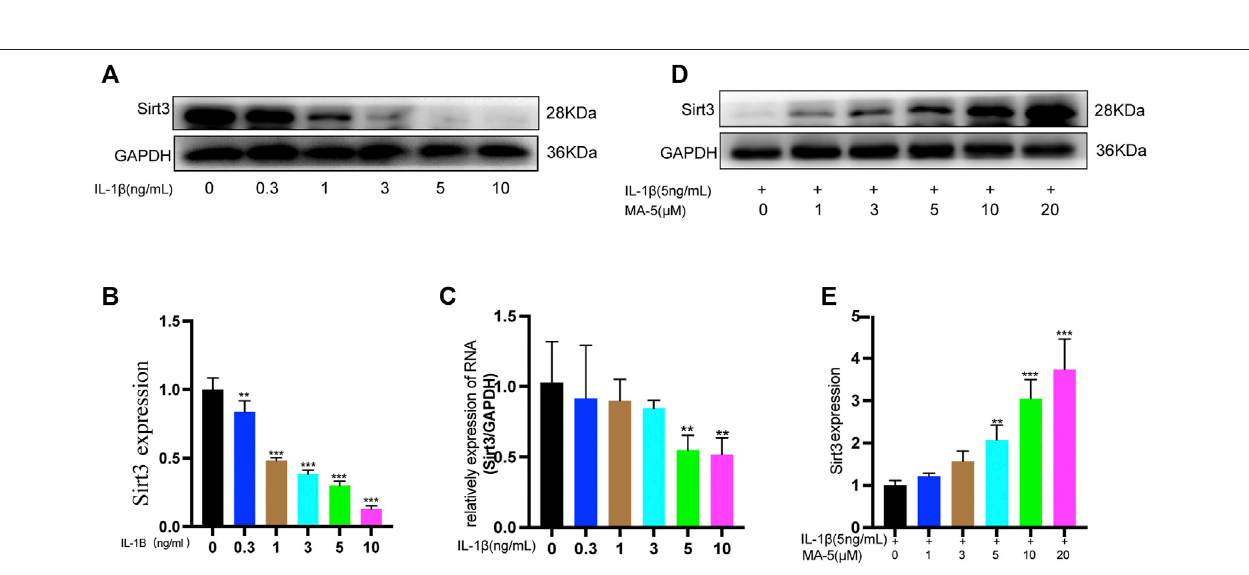
Frontiers in Pharmacology |